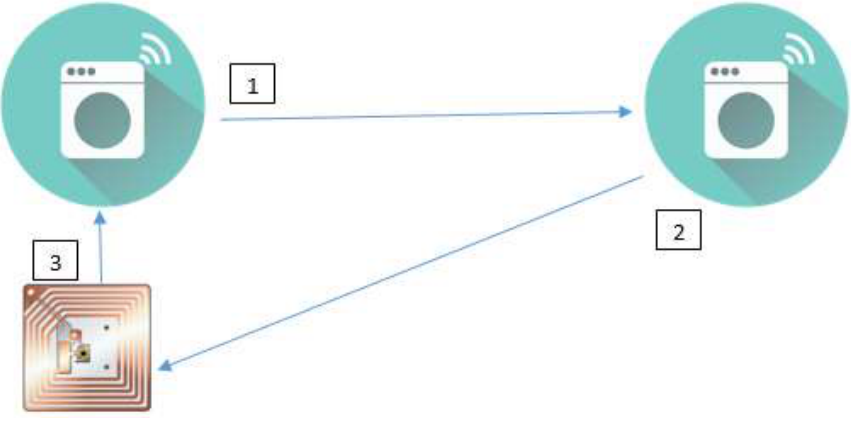
Figure 9. Passive sensor tag placement near other IoT devices to add extra sensing capabilities.